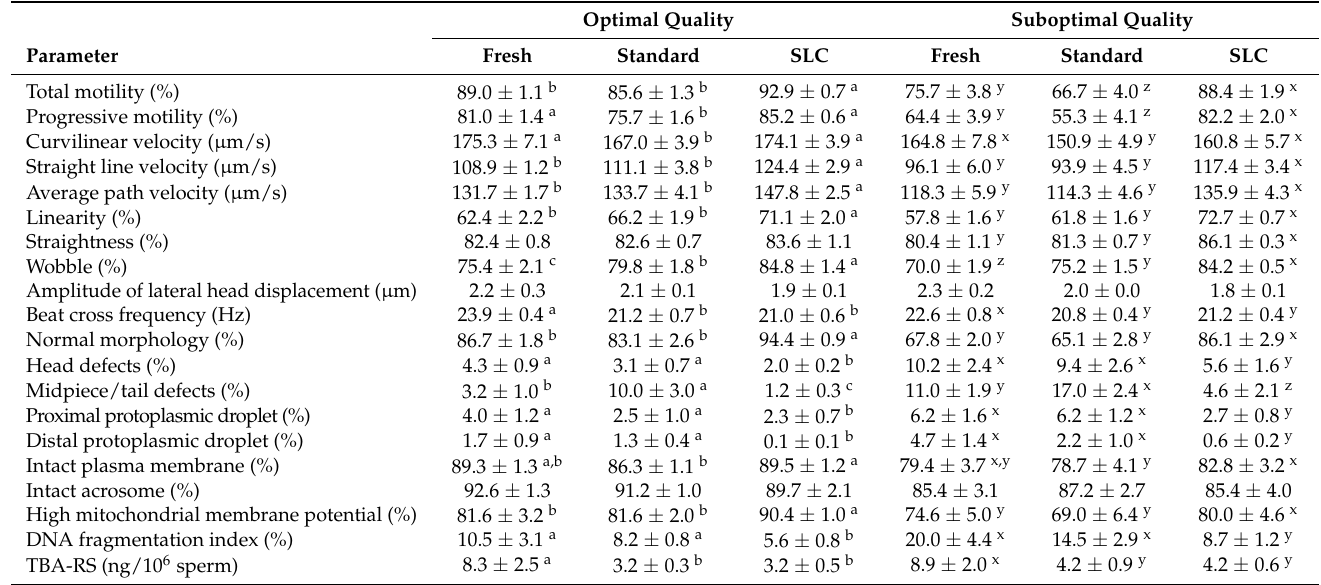
Table 2. Semen parameters (mean ± SEM) of optimal quality ejaculates (normal morphology ≥ 80%) and suboptimal quality ejaculates (normal morphology between 60 and 79%) after collection (Fresh), standard centrifugation (Standard), and single-layer centrifugation (SLC) before freezing. Optimal Quality